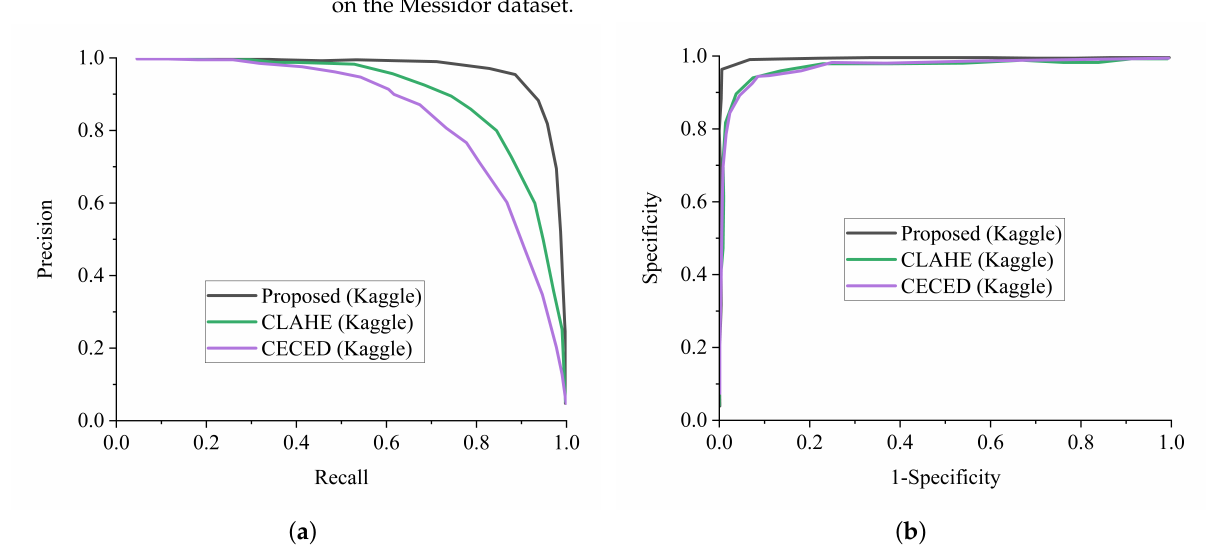
Figure 13. Comparison report of our model with single-channel models on the Kaggle dataset. ( a ) Precision-recall curve for our proposed model in comparison with the single-channel model on the Kaggle dataset. ( b ) ROC curve for our proposed model in comparison with the single-channel model on the Kaggle